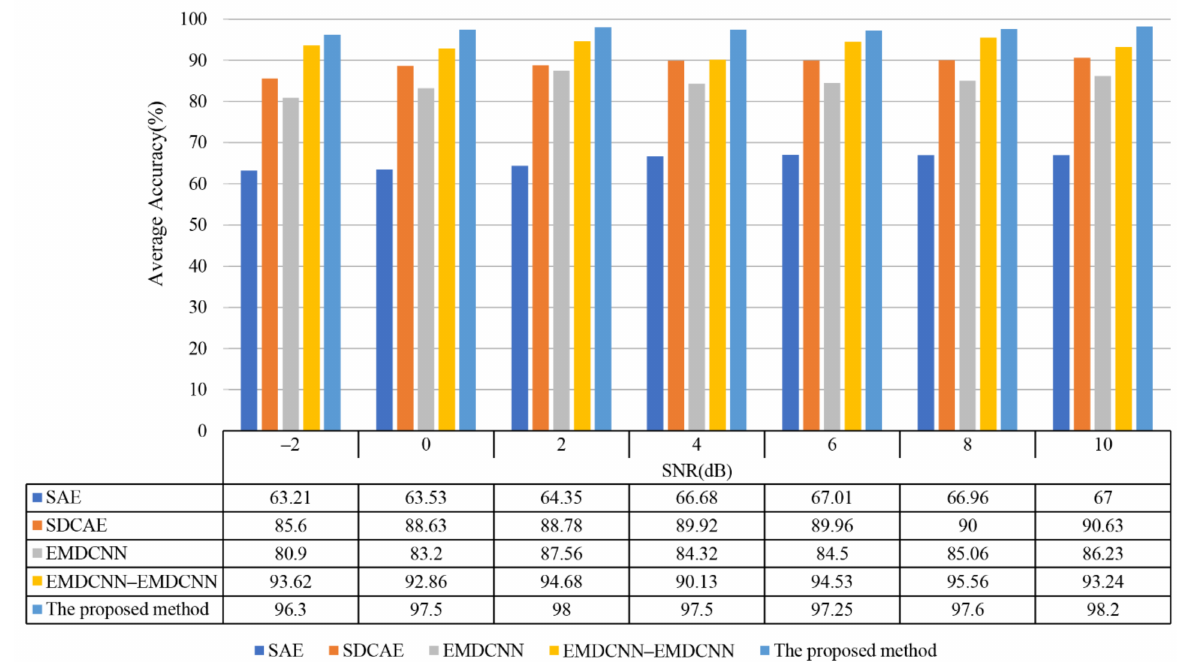
Figure 12. Average accuracy (%) of different methods for waterproof valve fault diagnosis at different signal-to-noise